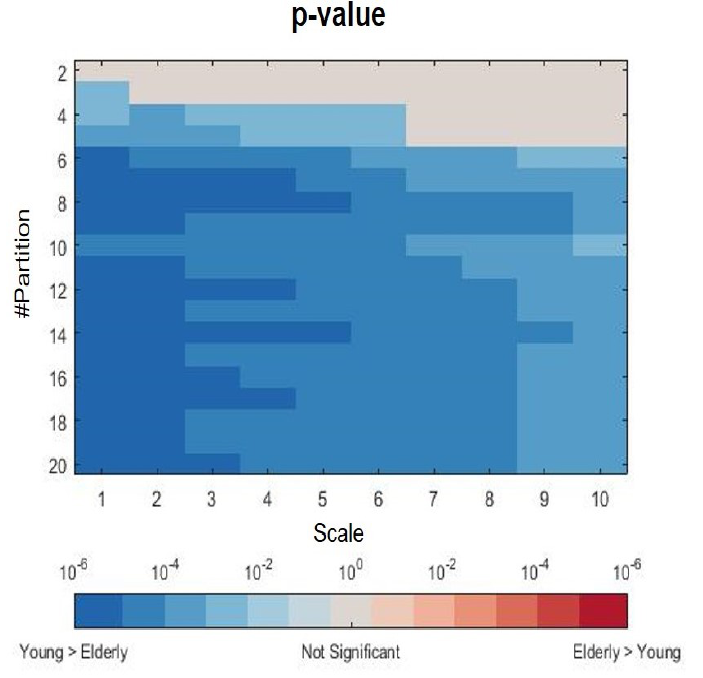
Figure 4. Distribution of p -values from nonparametric Mann–Whitney test for unpaired samples for the young vs. elderly comparison for each scale and